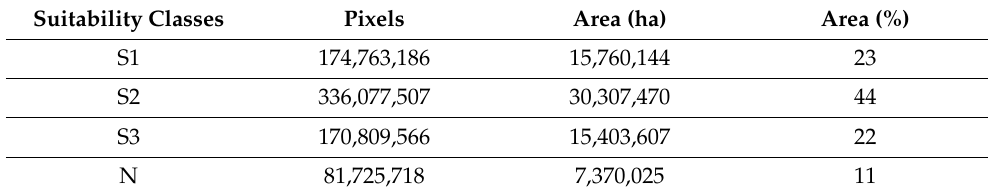
Table 4. Vineyard locations at different suitability classes distributed among the provinces of